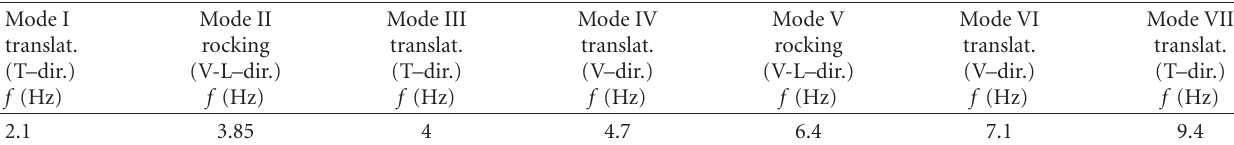
Table 1: Modal frequencies of vibration of the Adolphe Bridge for the three components of motion. The values assembled in this table are also indicated in Figure 6(b) as black dashed lines. Mode I